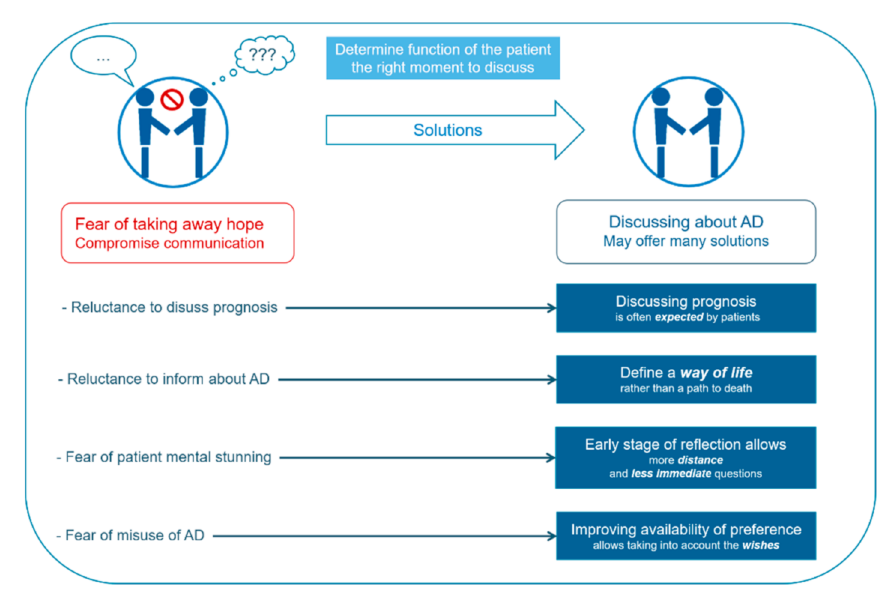
Figure 2. Main parameters associated with knowledge of advance